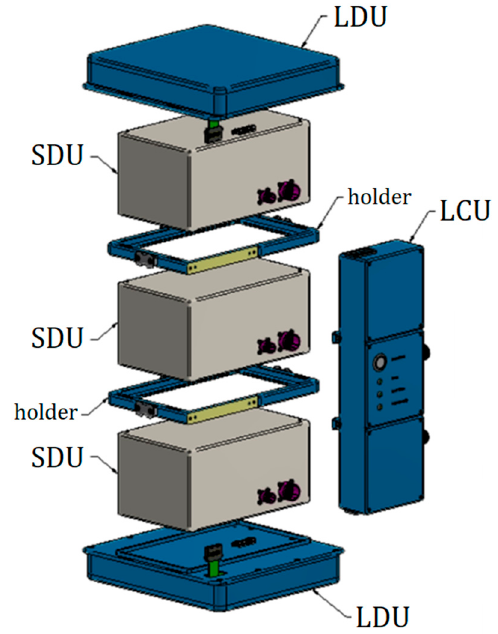
Figure 1. Sketch of the LIDAL detector. It consists of two LIDAL Detector Units (LDUs), containing fast timing scintillator bars and placed 49 cm apart, and three Silicon Detector Units (SDUs) from ALTEA. The LIDAL Collector Unit (LCU) and the data acquisition unit (DAU) (here not shown) manage data acquisition.